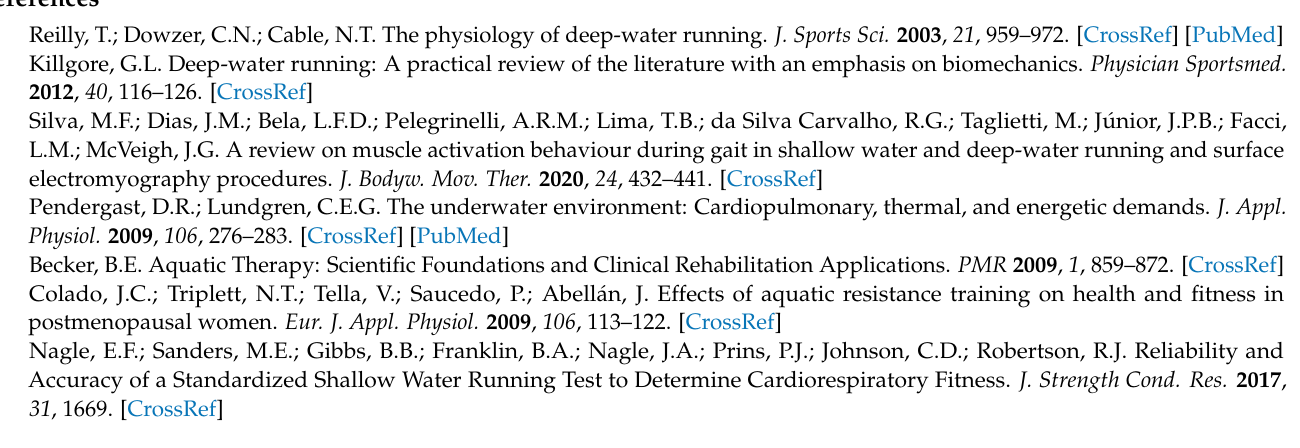
Criteria, Table S3: Selected components from Downs and Black’s Checklist for measuring study quality, Table S4: Benefits of DWR among three target populations